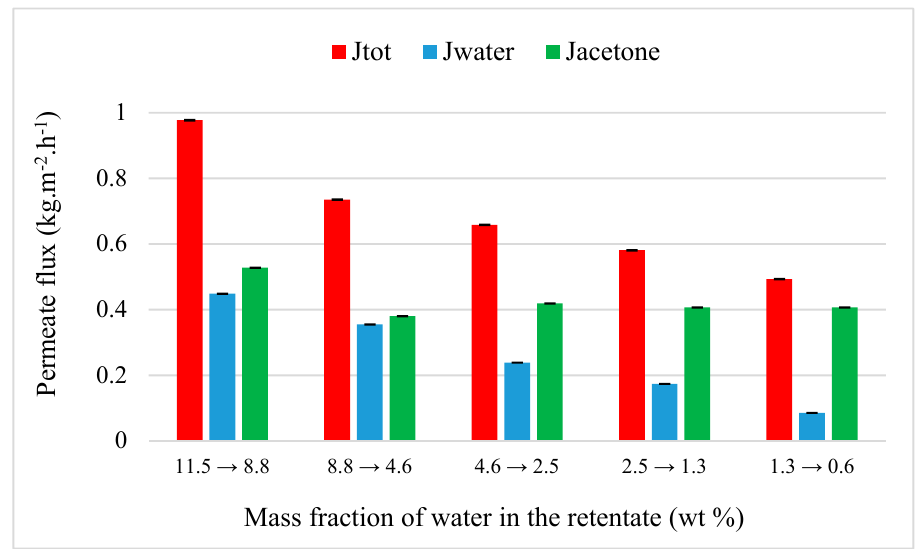
Figure 5. Evolution of flux as the function of the inlet water composition from a binary acetone-water mixture (90/10 wt%) through M2 at 30 °C. Membranes 2019 , 9 , x FOR PEER REVIEW